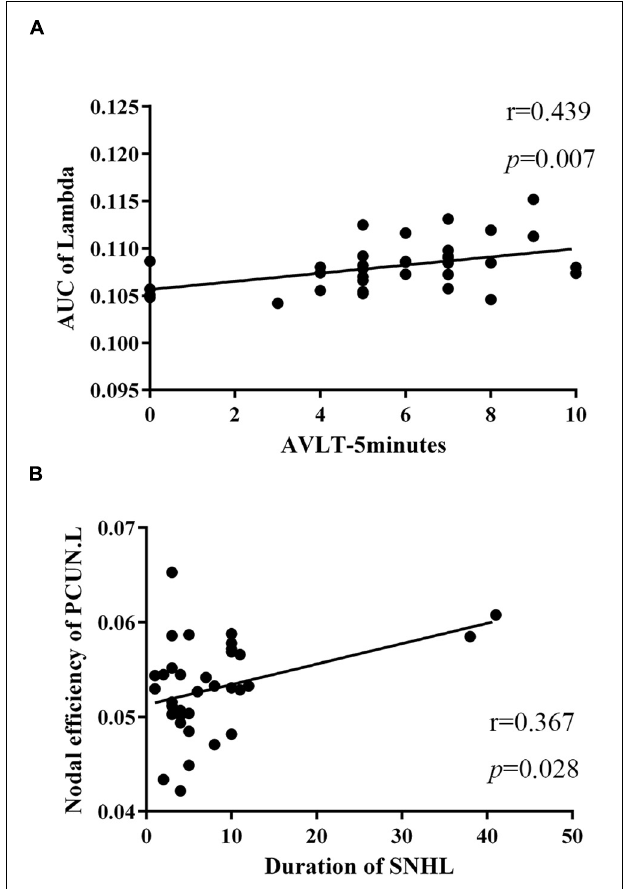
FIGURE 5 | Relationships between topologic properties and clinical measurements in the SNHL group. (A) The AUC of lambda was positively correlated with scores of AVLT-5 min ( r = 0.439, p = 0.007); (B) nodal efficiency of PCUN.L showed positive correlation with duration of SNHL ( r = 0.367, p = 0.028). SNHL, sudden sensorineural hearing loss; AUC, area under curve; AVLT, auditory verbal learning test; PCUN,